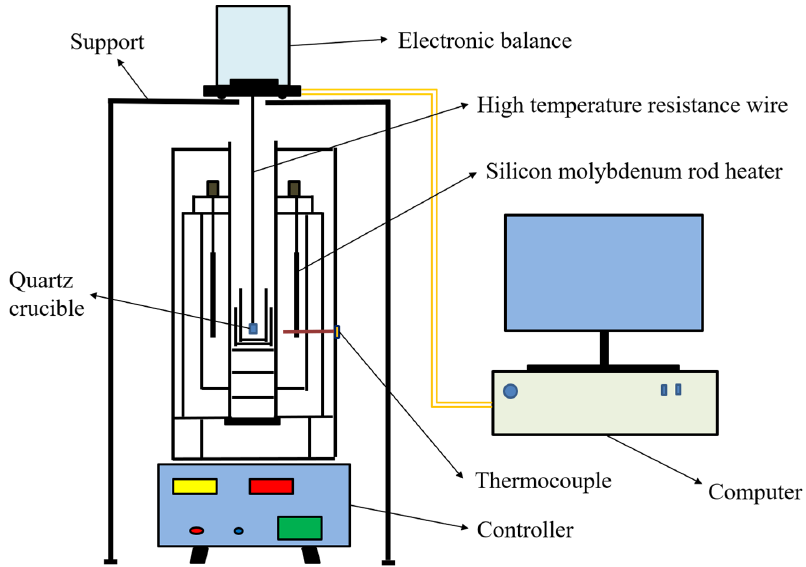
Figure 2. Schematic diagram of a high ‐ temperature resistance furnace for calcination of limestone.